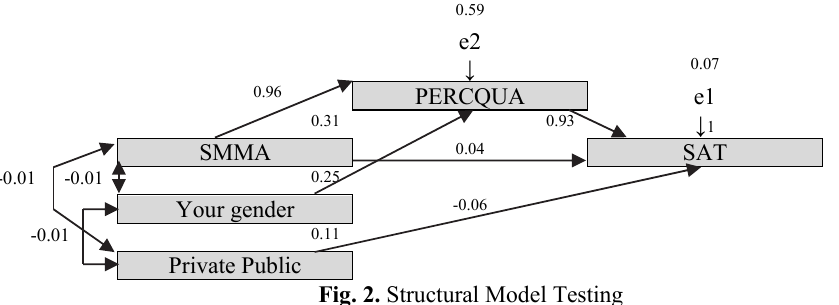
Fig. 2. Structural Model Testing